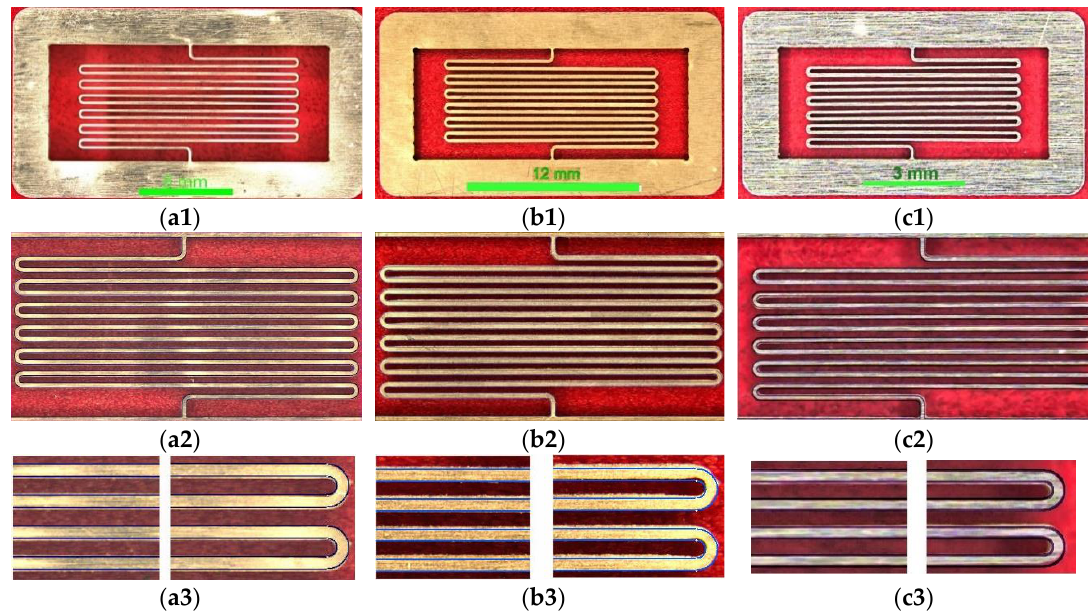
Figure 28. Downsized stainless steel flexures cut with µ AWJ nozzlles on MicroMAX: flexure with frames ( a1 , b1 , and c1 ); tool paths superimposed onto flexure elements ( a2 , b2 , and c2 ); and tool paths superimposed onto flexure elements—zoomed in ( a3 , b3 , and c3 ).